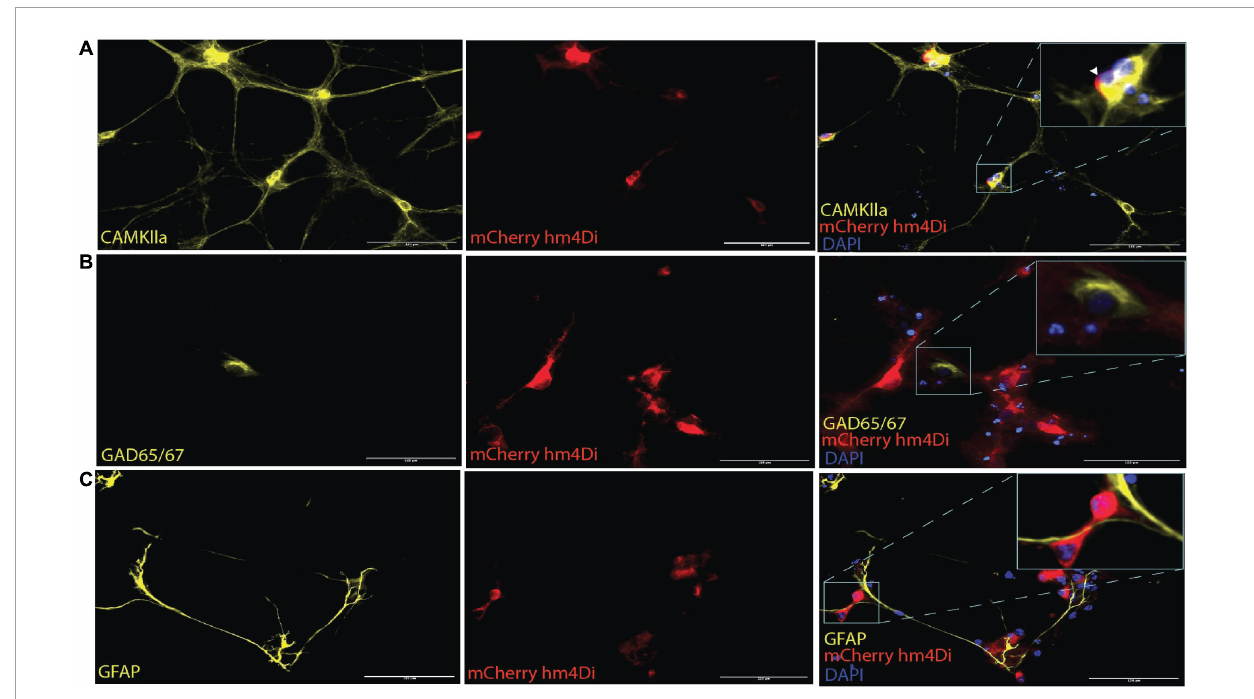
FIGURE3 AAV2/1 hM4Di designer receptors exclusively activated by designer drugs (DREADDs) expression in neurons in vitro . (A) The mCherry antibody was used to enhance the fluorescent of the hM4Di receptors, which were positively colocalized with the somata of CaMKlla positive neurons. (B) GAD65/67 expression indicated the presence of inhibitory neurons and showed no soma colocalization mCherry hM4Di expression. (C) Glial fibrillary acidic protein (GFAP) antibody was used to label astrocytes in the culture which also showed no soma colocalization with mCherry hM4Di expression. Scale bar = 125 µ m.